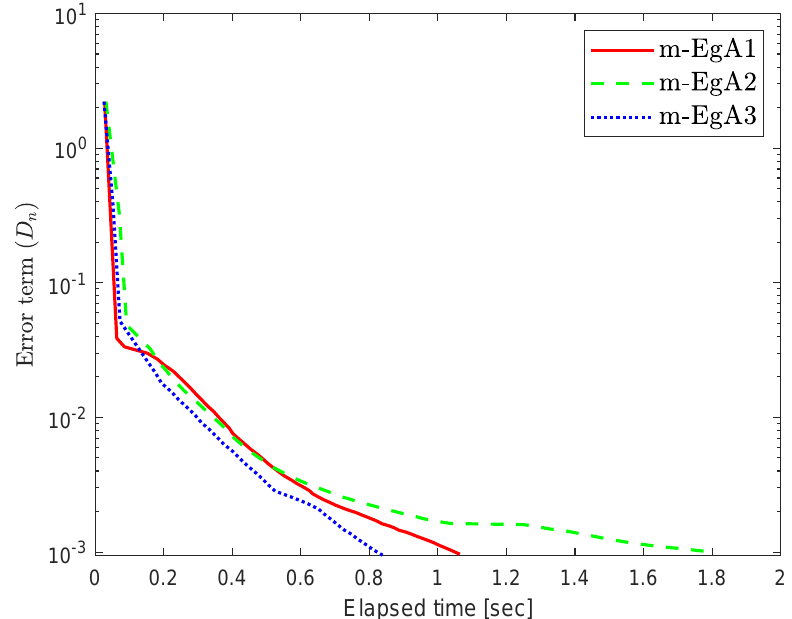
Figure 2. Numerical behaviour of Algorithm 1 compared to Algorithm 1 in [30] and Algorithm 2 in [30] for Example 1, when m =